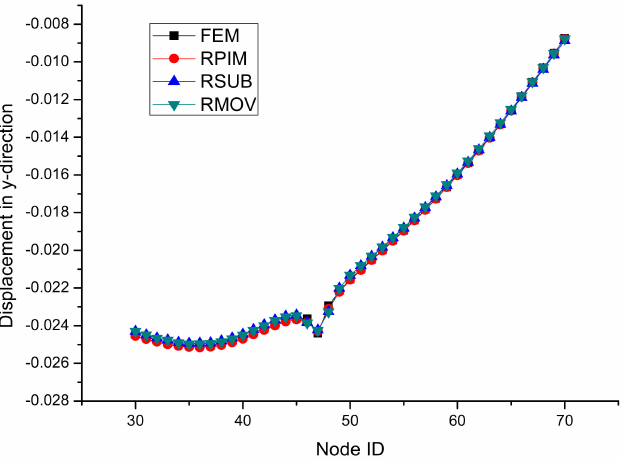
Figure 21. Displacement in the y-direction along the upper side of the